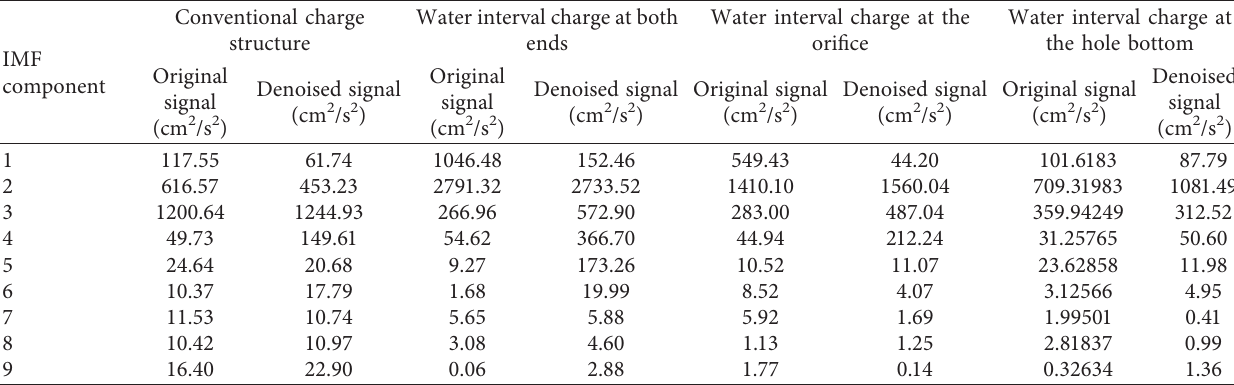
Figure 8: Energy distribution of the IMF layer. (a) Original signals. (b) Denoised signals. Table 4: Energy of each IMF layer before and after noise reduction for four charge